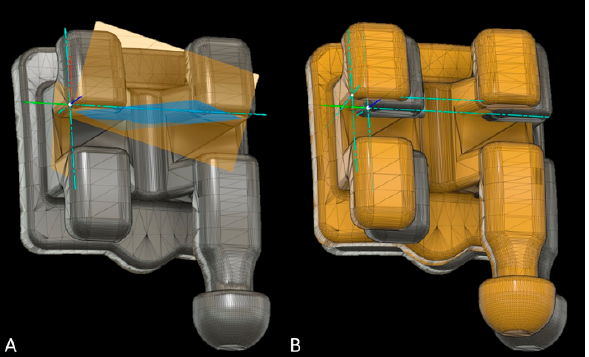
Figure 6. Measurement of bracket transfer accuracy with Fusion software; ( A ) reference bracket with the local coordinate system defined through the three planes (yellow and blue). ( B ) Reference bracket and test bracket (yellow) to measure the linear and angular bracket bonding accuracy (mm, degree).